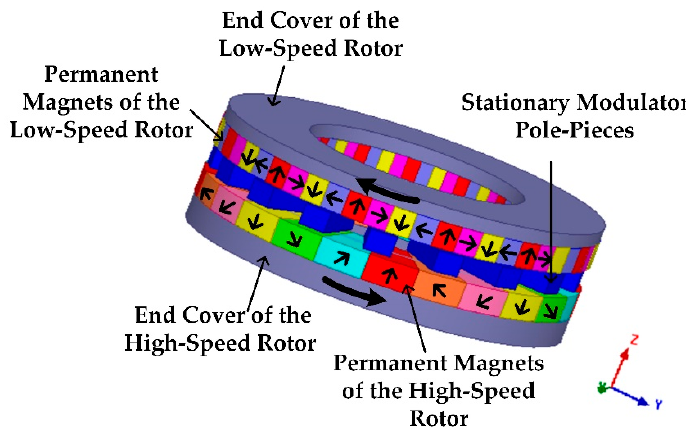
Energies 2019 , 12 , x FOR PEER REVIEW Figure 1. Topology of the general axial magnetic gear (AMG). Figure 1. Topology of the general axial magnetic gear (AMG).